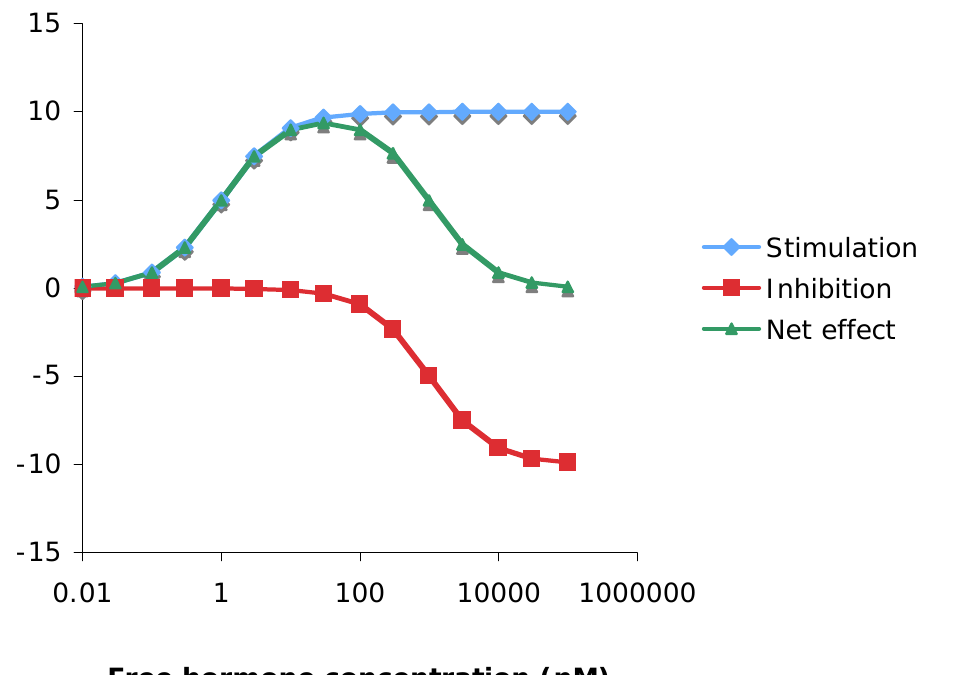
Figure 6. Predicted responses for a response to stimulation by a ligand that binds to a receptor with an activating site with Kd of 1nM, and to an inhibitory site with Kd of 1 μ M, assuming a receptor concentration of 10